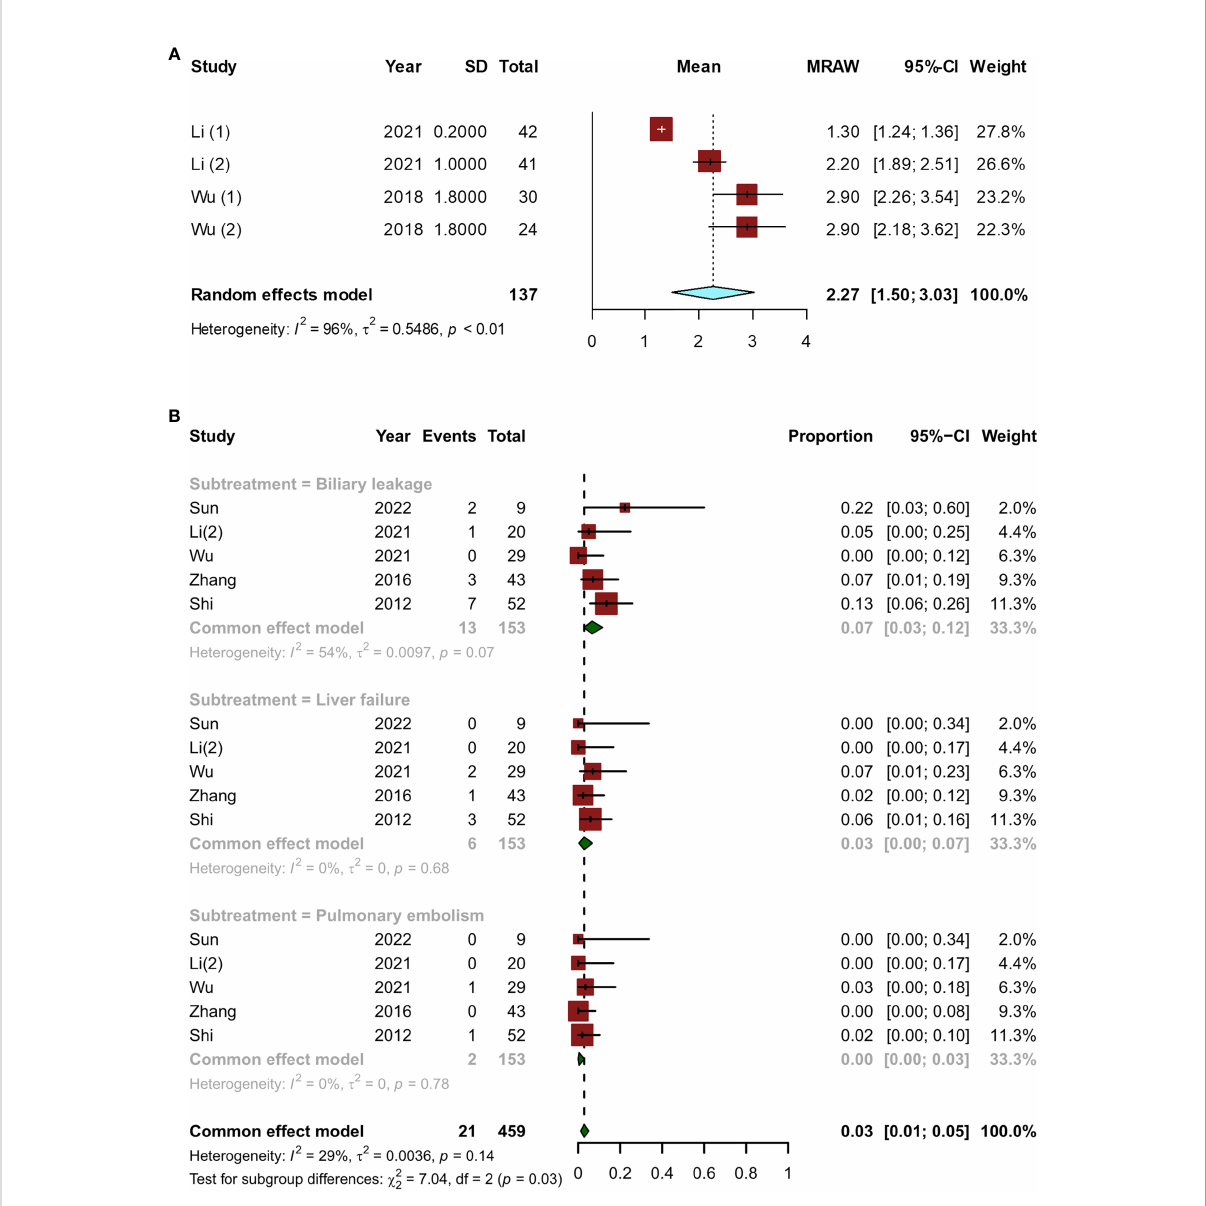
FIGURE 5 Short-term indicators in patients undergoing surgery after conversion therapy, including (A) the time between initial conversion therapy and resectable criteria; (B) major postoperative